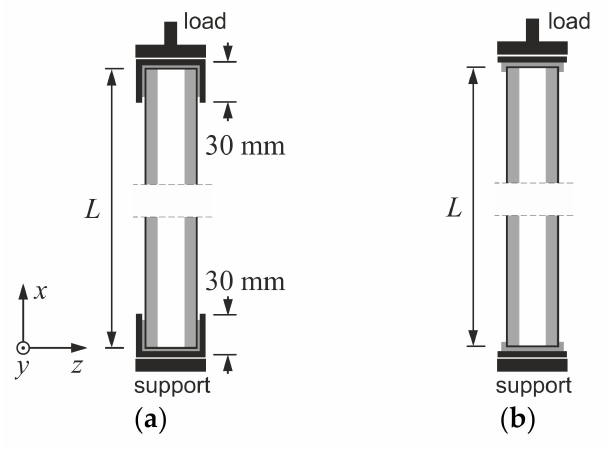
Figure 2. Schematic diagram of small-scale laboratory tests: ( a ) L1 and L2, ( b )